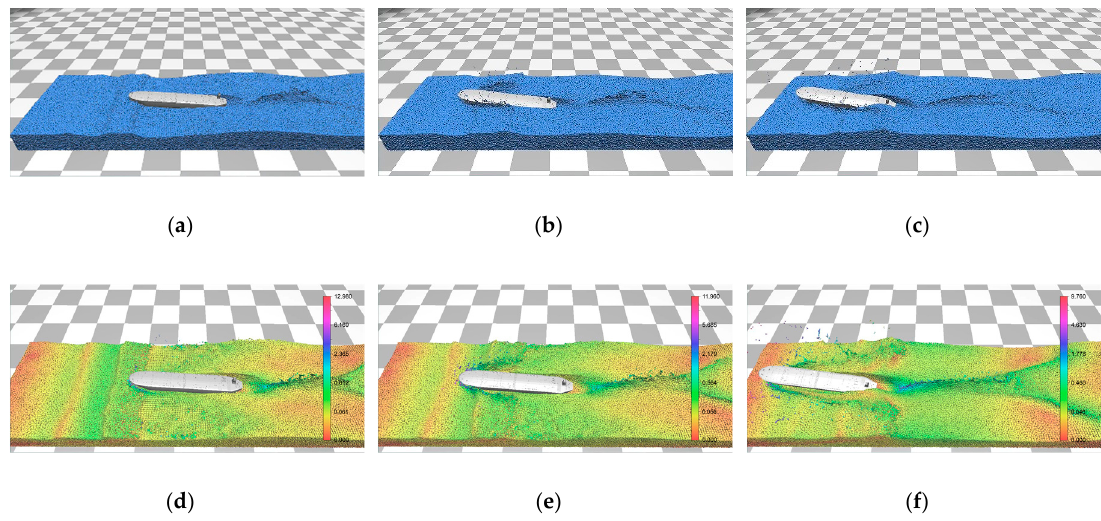
Figure 13. Scene of tanker sailing in swell wave, with 312.8 k fluid particles: ( a – c ) selected three different time steps; and ( d – f ) velocity distributions of fluid particles. The time instances in ( a – c ) are the same as in ( d – f ), respectively. The color bars on the right sides of ( d – f ) denote the modules length of the velocity. The unit of velocity in ( d – f ) is m/s.